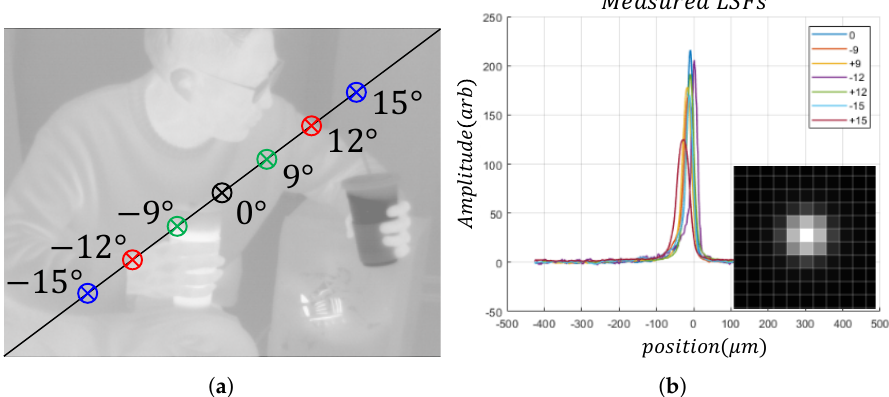
Figure 11. Application to LWIR image deconvolution. ( a ) Points of measured LSFs. The measured LSFs were obtained by varying the distance from the optical axis. Seven LSFs were measured at the points marked with ⊗ by the optical device; ( b ) visualized LSFs and their PSF. The PSF is reconstructed by the Radon transform [41] based on the LSFs. Averaging of LSFs and A2D conversion considering the pixel size of the LWIR sensor have been utilized to reconstruct the PSF.